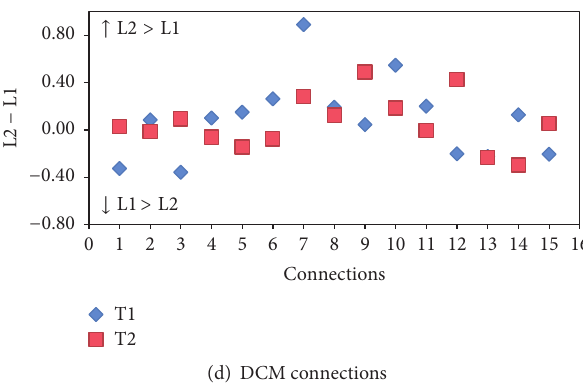
Figure 4: Patient 2. (a) The T1-weighted MRI image at T1 shows an epidural hematoma with pressure over the operation site on the left frontobasal area. (b) Pattern of brain activation in different conditions while picture naming, with an uncorrected 𝑝 < 0.001 for the main effects. (c) Behavioral results of the combined production scores in both languages, linguistic and nonlinguistic switching scores across sessions. ∗ represents 𝑝 value < 0.05. (d) Differences between L1 strength values and L2 strength values for each single connection across sessions. (1) ACC to LIFGTri. (2) ACC to LIFGOrb. (3) ACC to LC. (4) LC to ACC. (5) LC to LIFGTri. (6) LC to LIFGOrb. (7) LIFGTri to